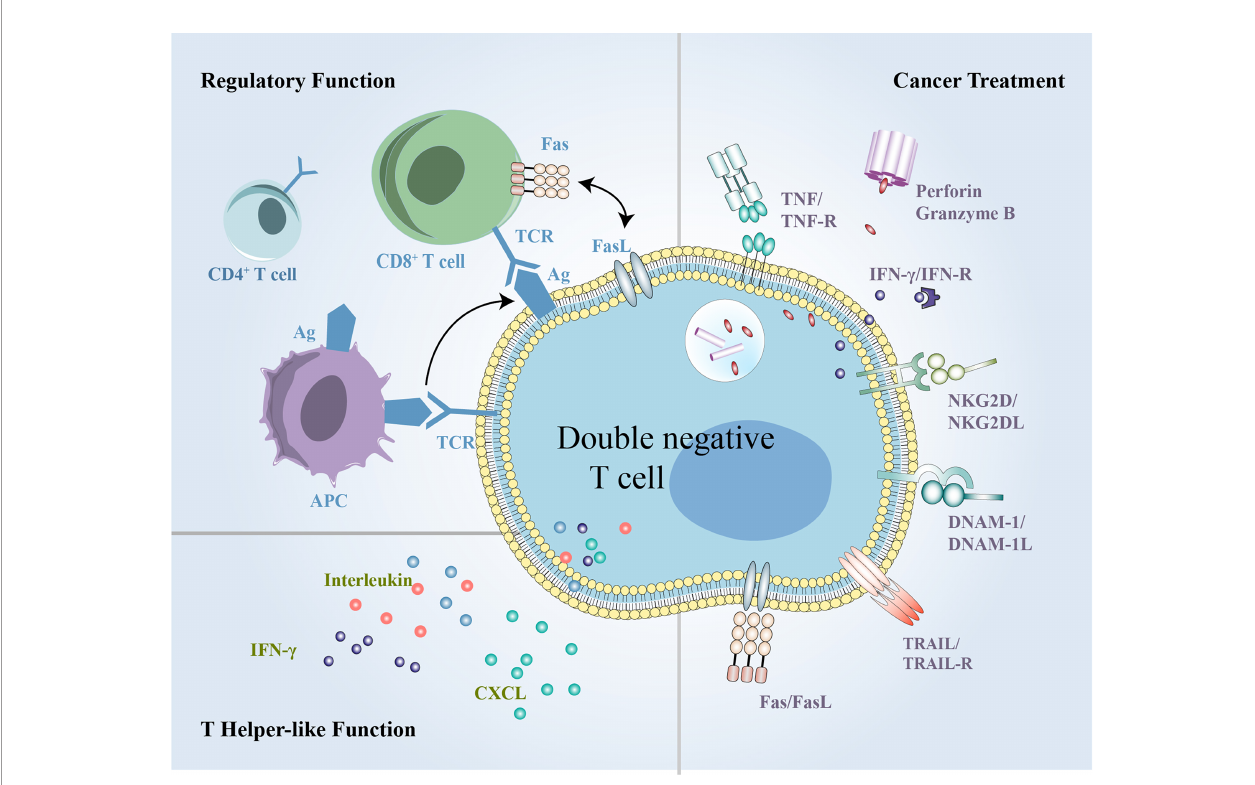
FIGURE 5 | The summary of multifunctional DN T cells in in fl ammation, immune disorders and cancer. DN T cells exert both regulatory and helper-like functions under different conditions and can exert antitumor activity in cancer treatment. DN,